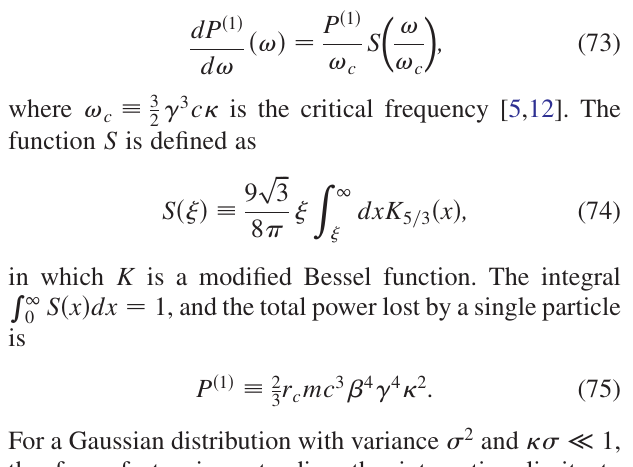
For a Gaussian distribution with variance (cid:10) 2 and (cid:7)(cid:10) (cid:7) 1 ,